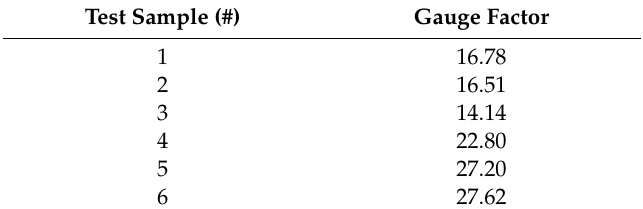
Table 3. Data for the gauge factor of the carbon paste-based